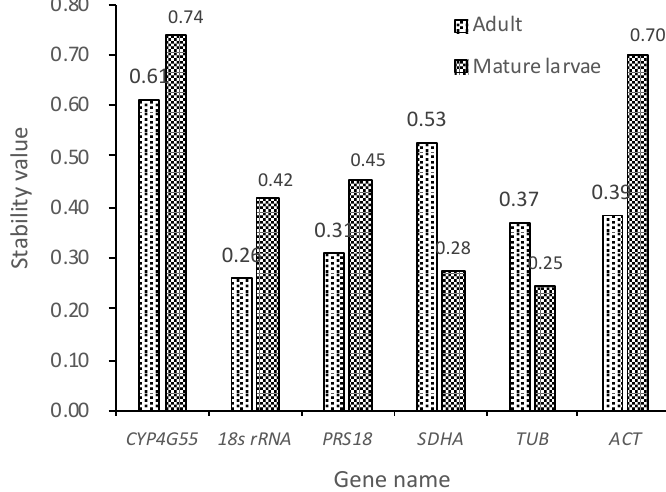
Figure 4. Expression stability of candidate reference genes in adults and mature larvae of D. valens evaluated using NormFinder. A lower stability value indicates a more stable expression.